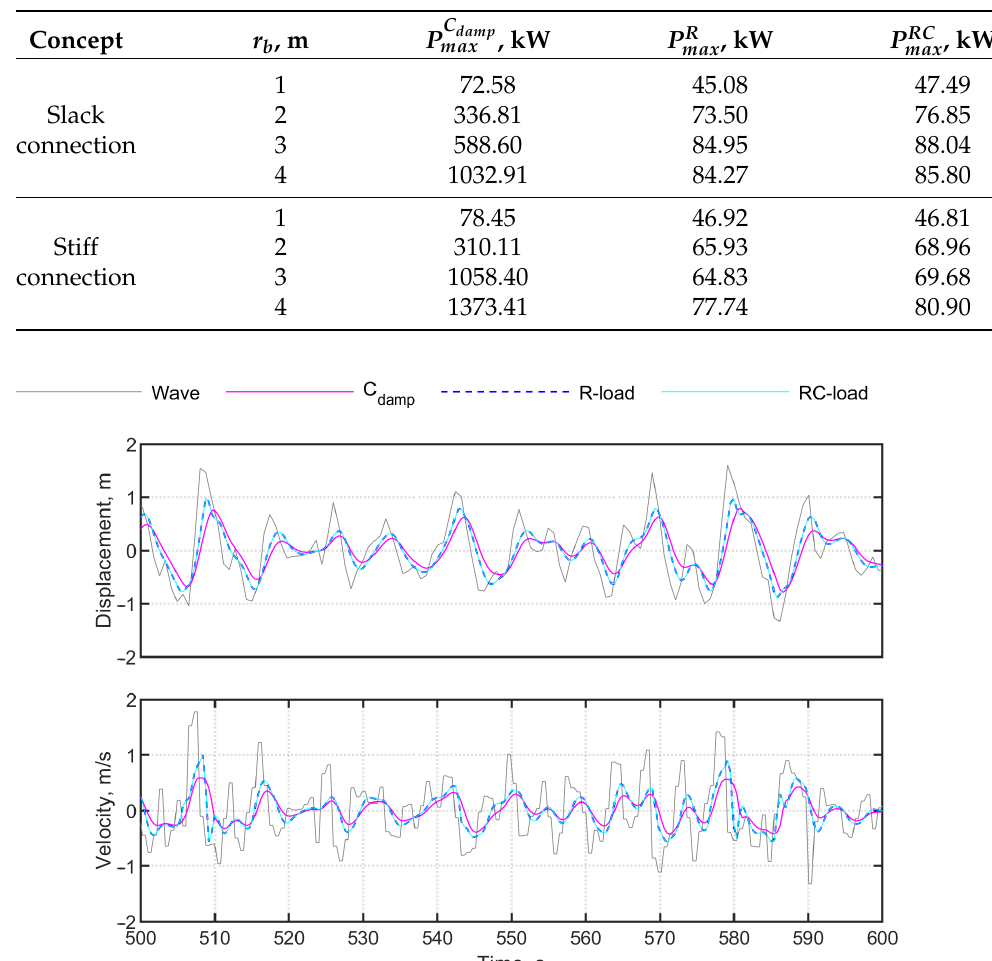
Table 6. Peak values of active power for each case.